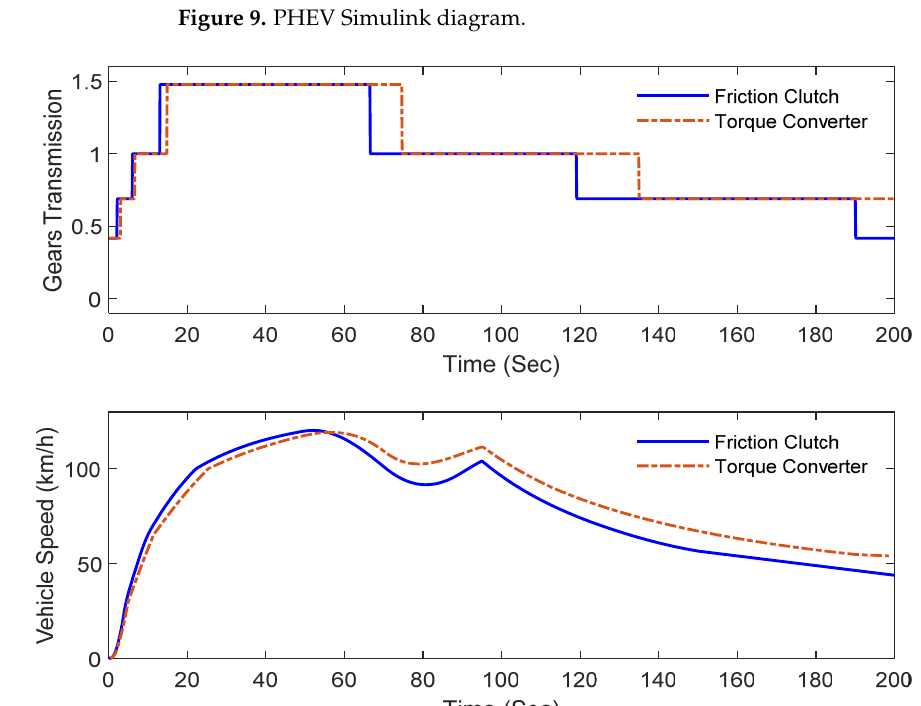
Figure 9. PHEV Simulink diagram.